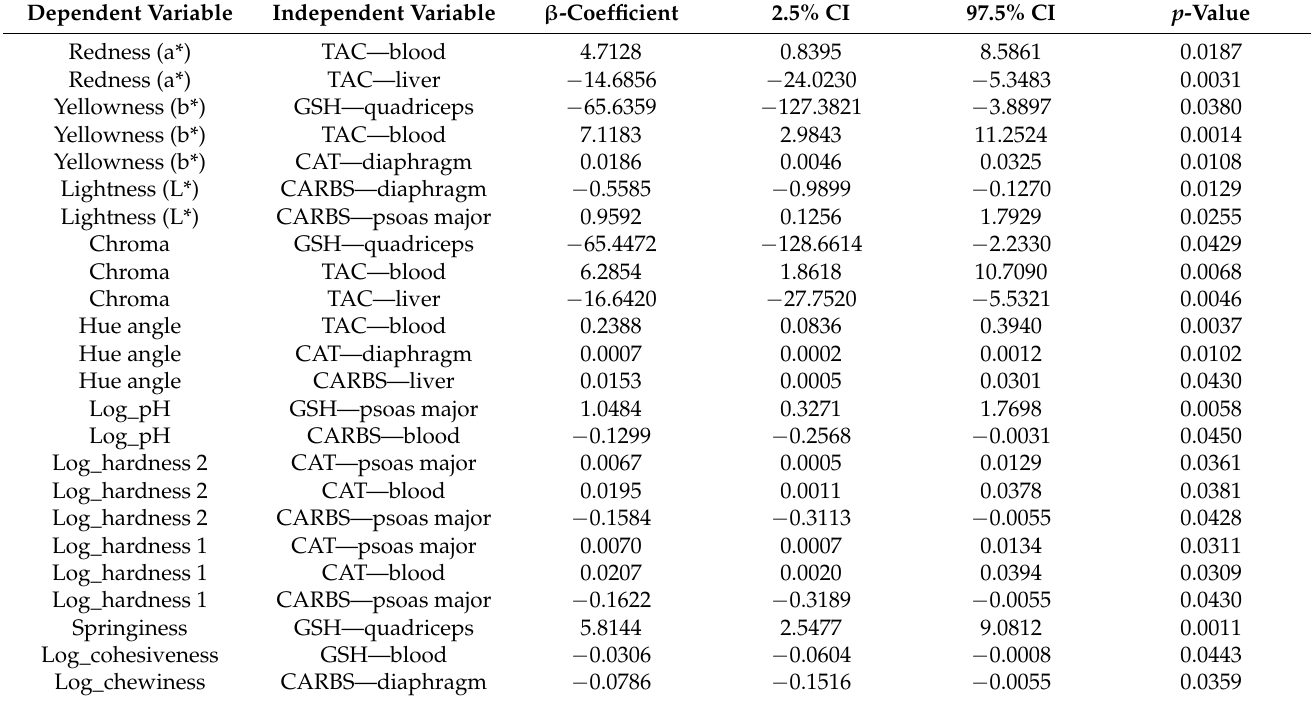
Table 3. Statistically significant effects of the redox status on the meat quality parameters ( β -coefficients, p -value and 95% confidence